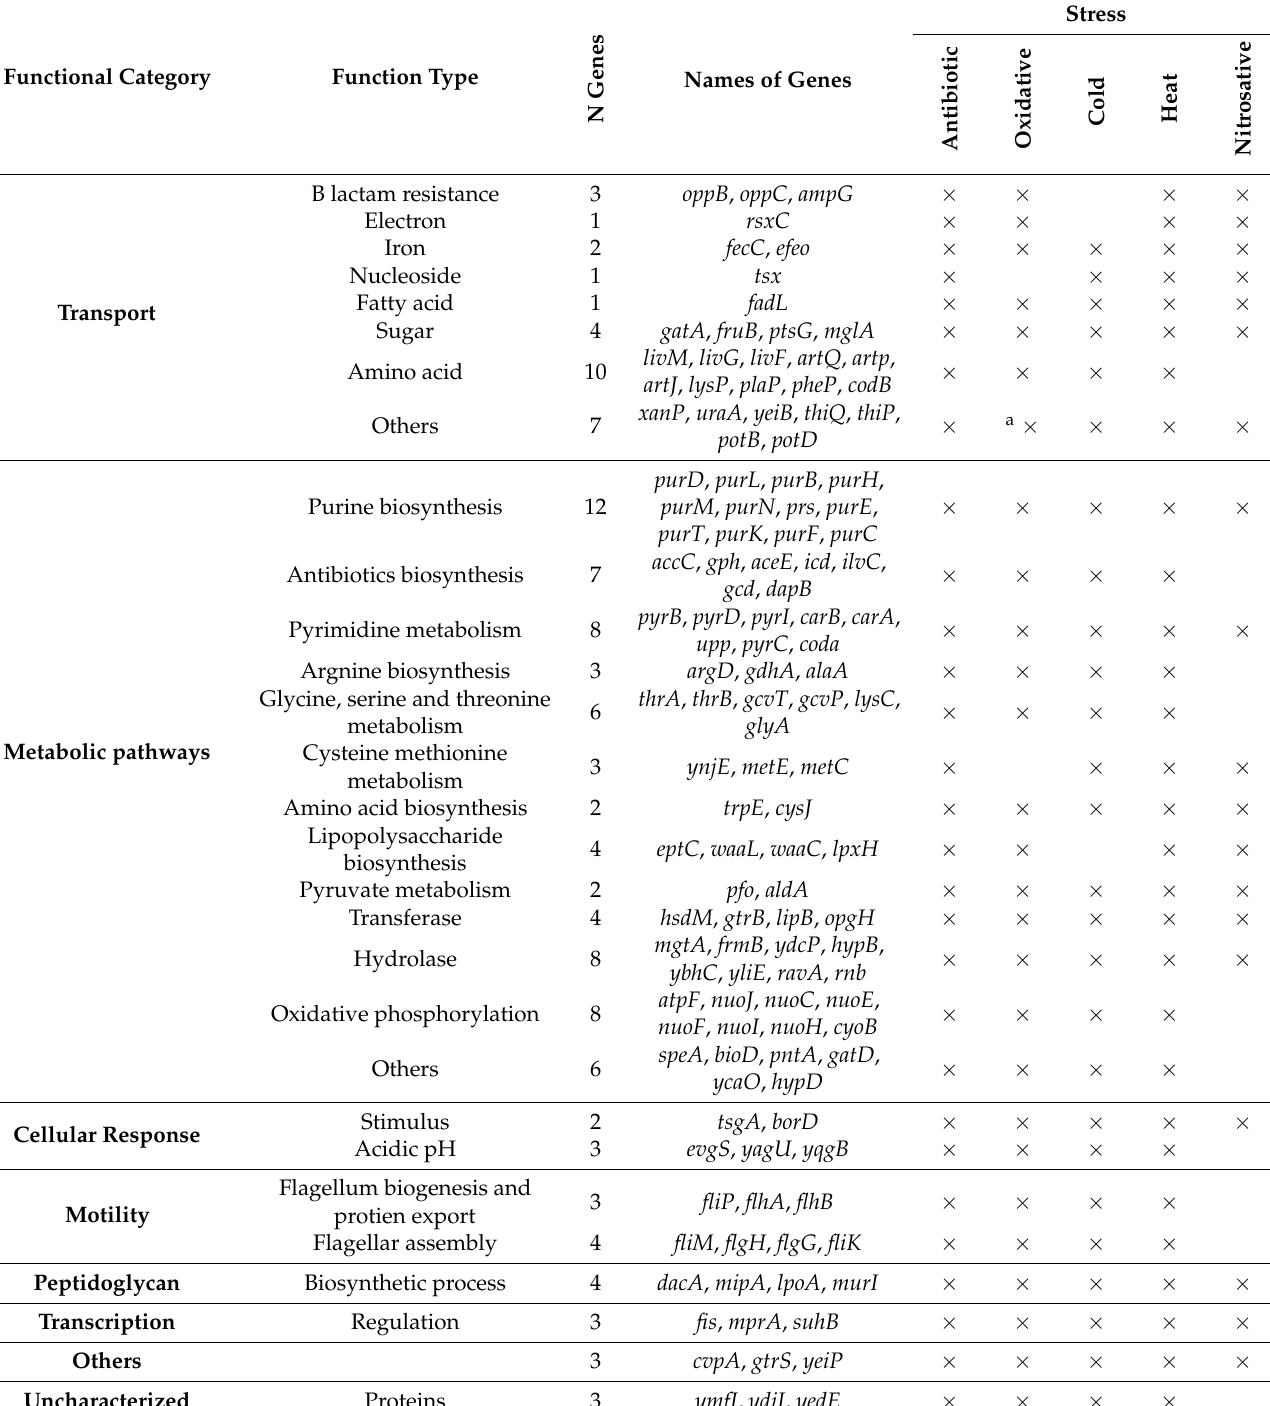
Table 3. Downregulated gene functions in multiple